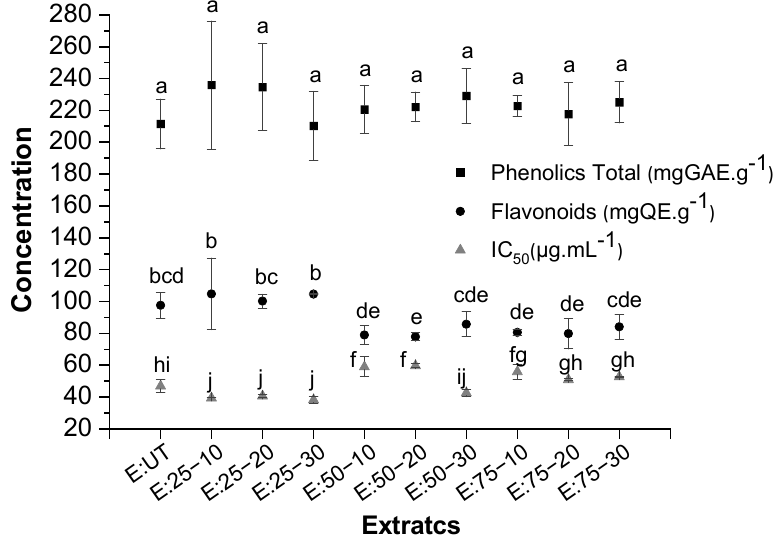
Figure 1. Analysis of the total content of phenolic compounds, flavonoids and the antioxidant activity (IC 50 ) of red propolis extracts obtained in different conditions. Values presenting the same letter in the same analysis do not show significant differences ( p > 0.05) in Tukey’s test at 95% confidence. Samples E:UT and E:25 − 30 presented values lower than the quantification limit for kaempferol. Average of analyses obtained from triplicates ( n = 3).